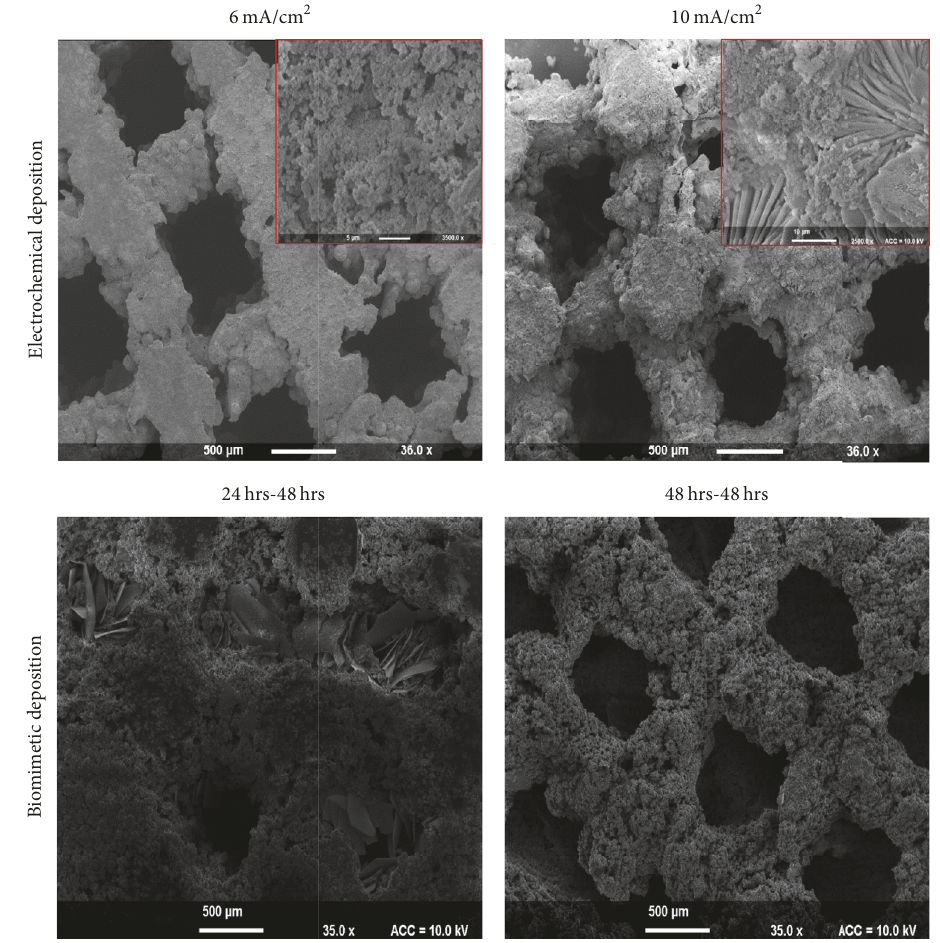
Figure 2: SEM micrographs of HAp coated Ti scaffolds using biomimetic and electrochemical